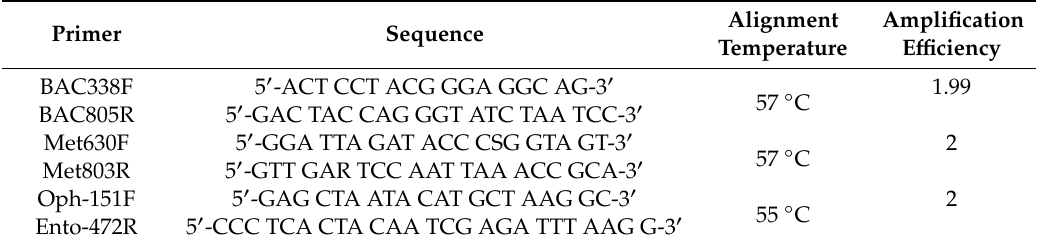
Table 2. Oligonucleotide primers used for the quantitative polymerase chain